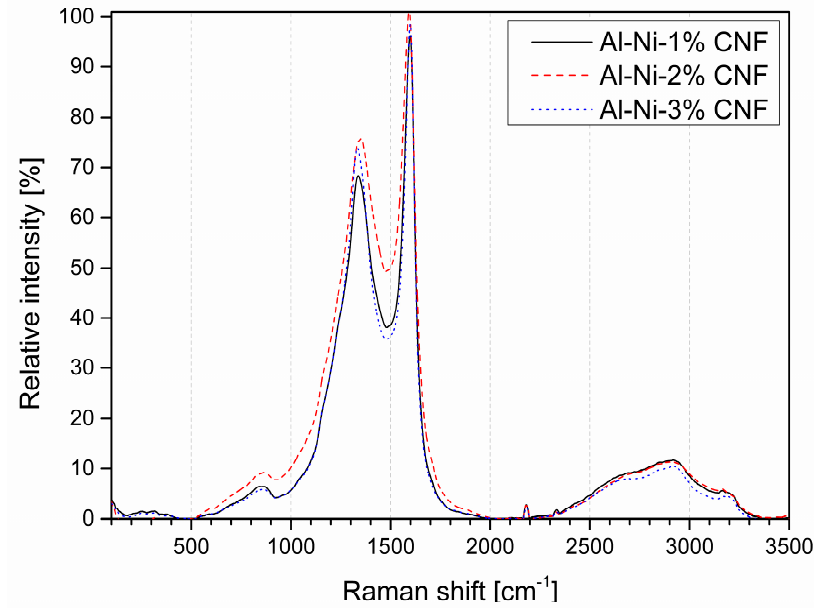
Figure 2. Raman spectra of aluminum with various weight content of CNF.